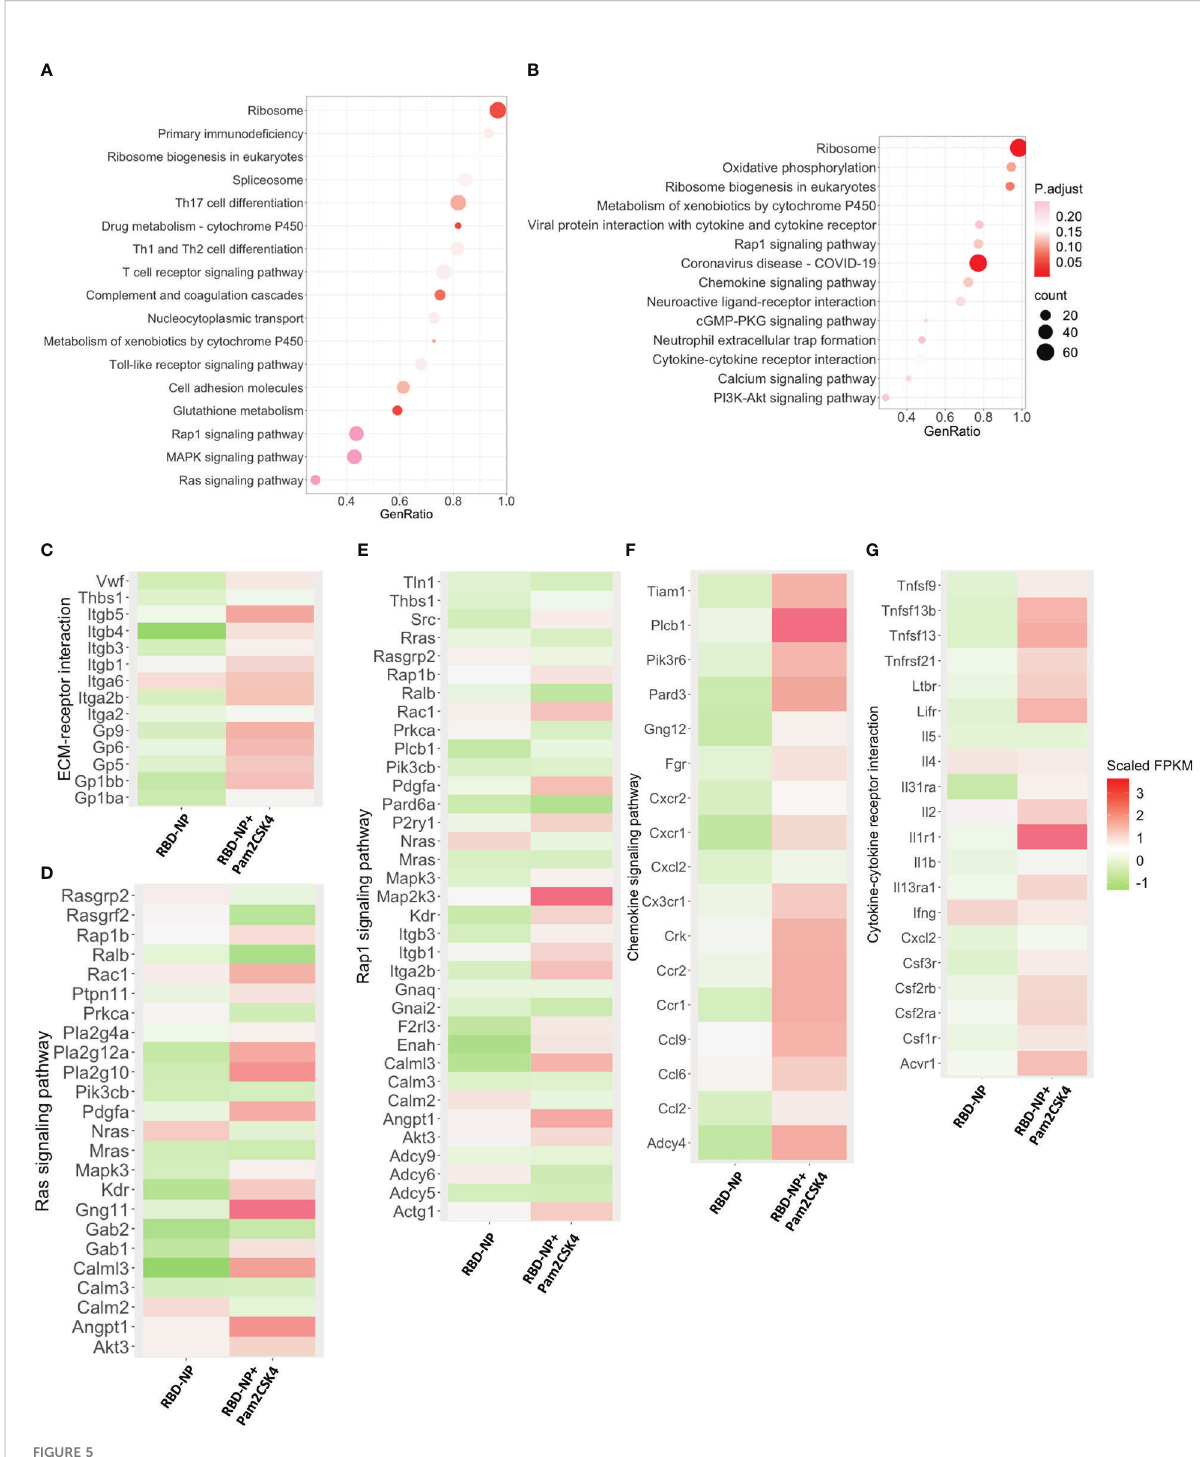
FIGURE 5 Transcriptional characterization of Pam2CSK4-adjuvanted SARS-CoV-2 nanoparticle vaccine. (A, B) Major gene enrichment maps of GSEA for peripheral leukocytes in the RBD-NP and RBD-NP+Pam2CSK4 groups of mice, respectively. Circles represent the number of genes involved in the gene pathway. (A) three days after immunization; (B) 7 days after immunization. (C – E) . Heat map of genes associated with ECM-receptor interactions, Ras, and Rap1 signaling pathways showing the activation enrichment in the Pam2CSK4 + RBD-NP group compared to the RBD-NP group at day 3 post-immunization. (F, G) A heat map of genes associated with chemokine signaling and cytokine-cytokine receptor interactions pathways shows activation enrichment in the Pam2CSK4 + RBD-NP group compared to the RBD-NP group at day 7 post-immunization. Color changes represent Scaled FPKM. RNA expression levels are indicated by red/green Scaled FPKM for high and low expression levels,